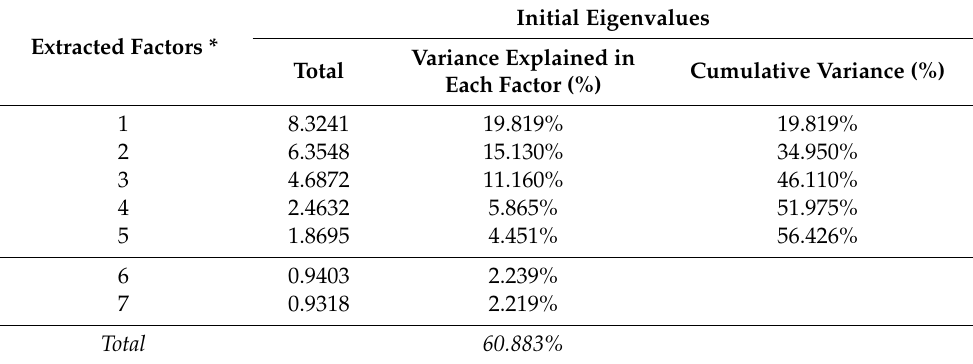
Table 3. Factors extracted, Initial Eigenvalues: percent Variance explained in each factor (%) and percent Cumulative variance